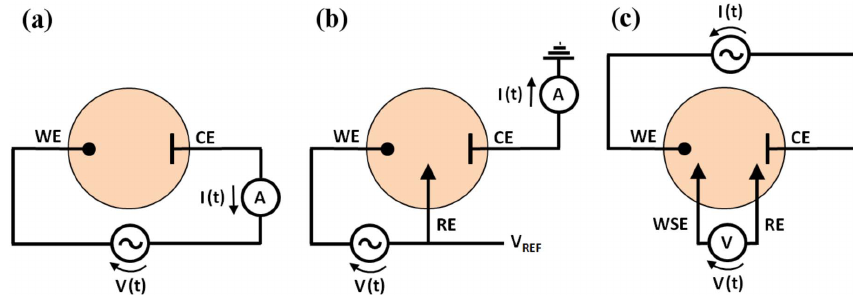
Figure 1. Measurement setup configurations used in EIS featuring (a) two electrodes, (b) three electrodes and (c) four electrodes.